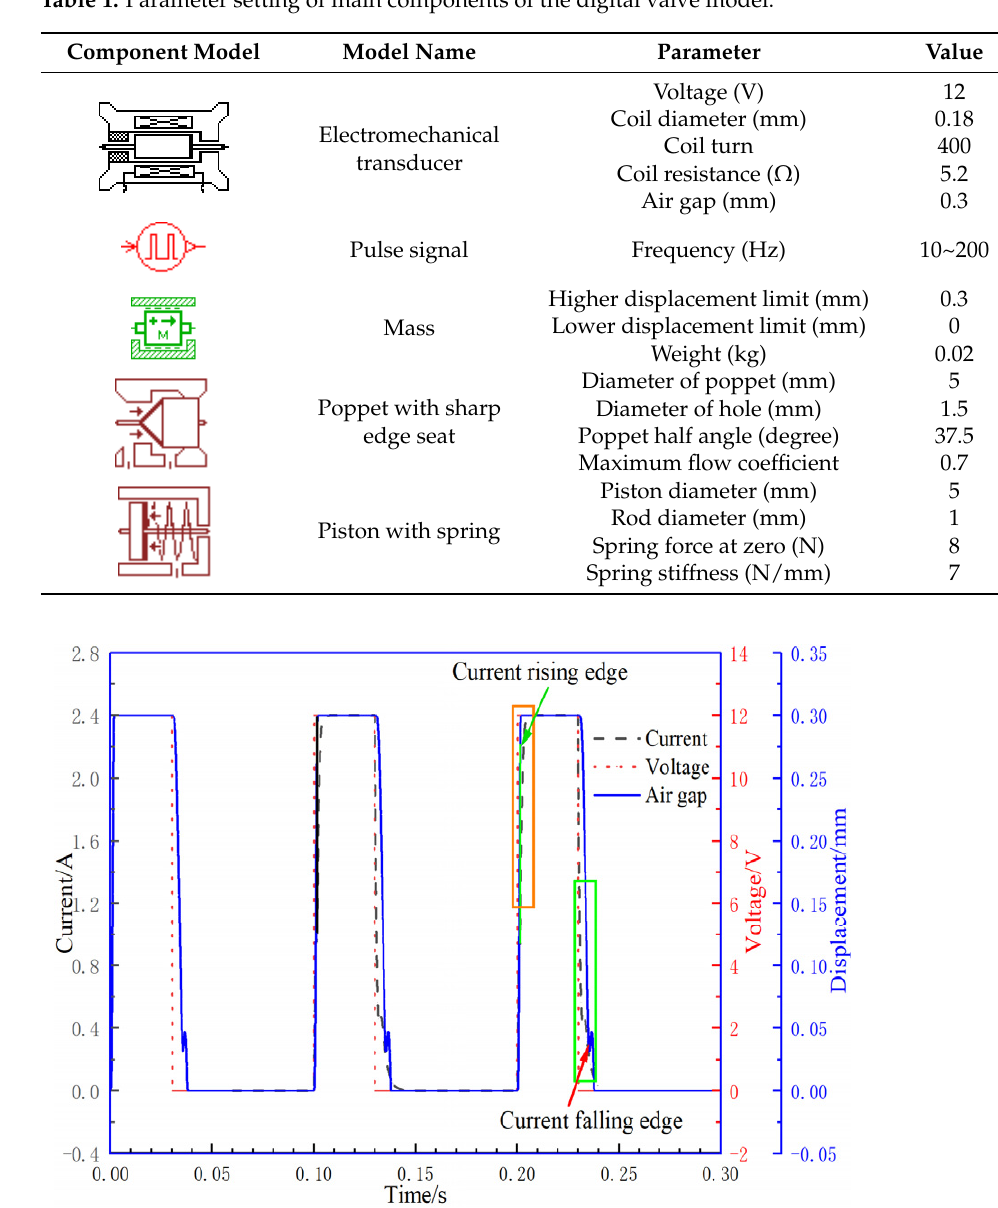
Piston diameter (mm) 5 Rod diameter (mm) 1 Spring force at zero (N) 8 Spring stiffness (N/mm) 7 In the simulation, the oil pressure is set to 35 bar, the duty cycle of the PWM control signal is 0.3, the frequency is 10 Hz, the control signal works ten cycles in 1 s and the